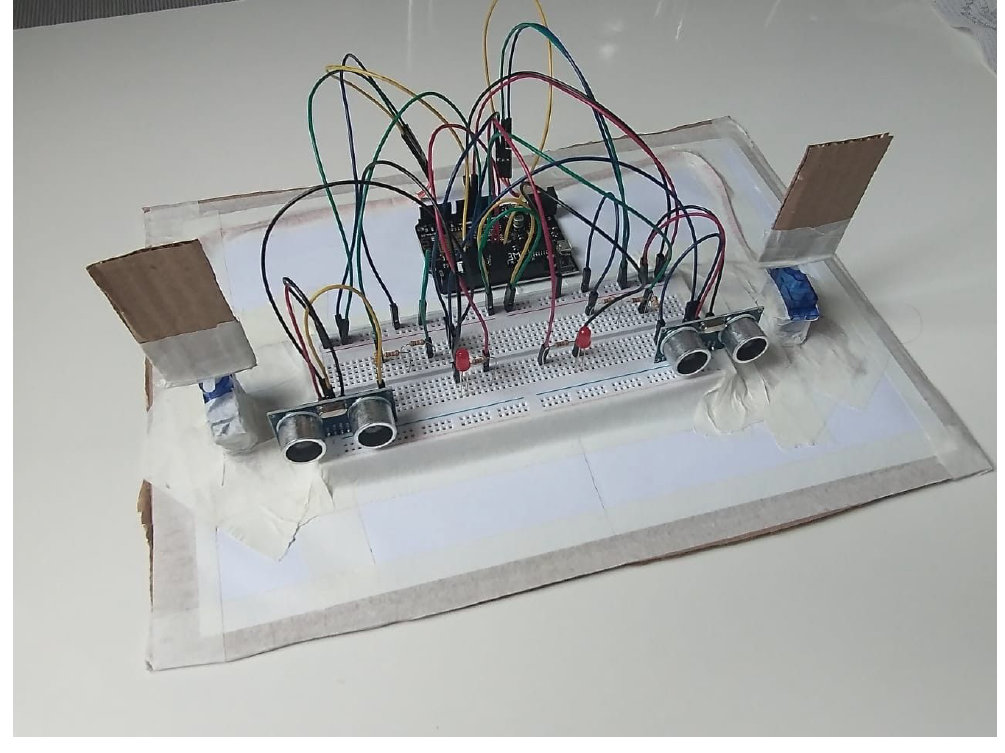
Figure 11. Smart Door project.